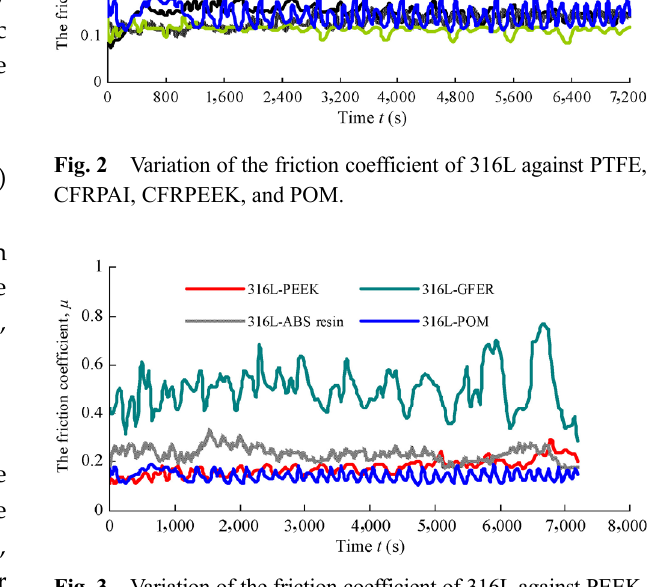
Fig. 3 Variation of the friction coefficient of 316L against PEEK, GFER, ABS resin, and